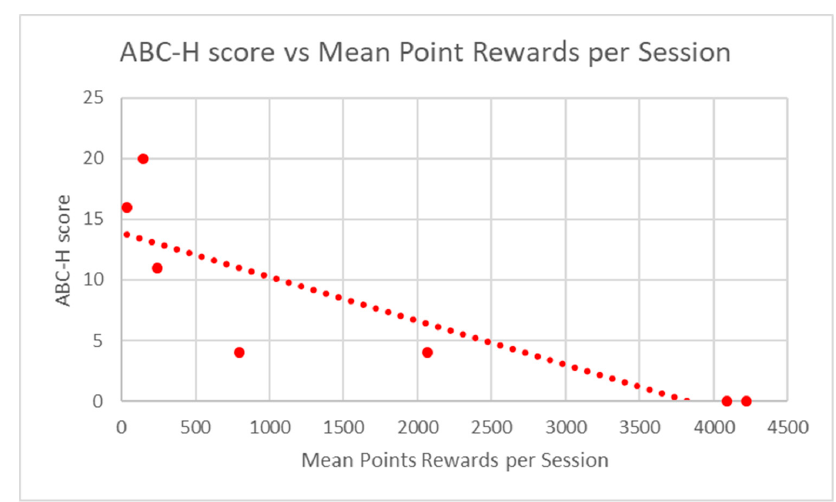
Figure 3. ABC-H Score vs. Mean Point Rewards Per Session. Figure 2. ABC-H Score vs Mean Point Rewards Per Session. Figure 2. ABC-H Score vs Mean Point Rewards Per Session.